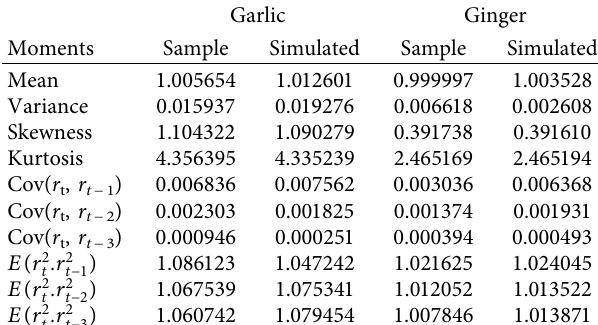
Table 2: Sample moments and simulated moments of return series. Garlic